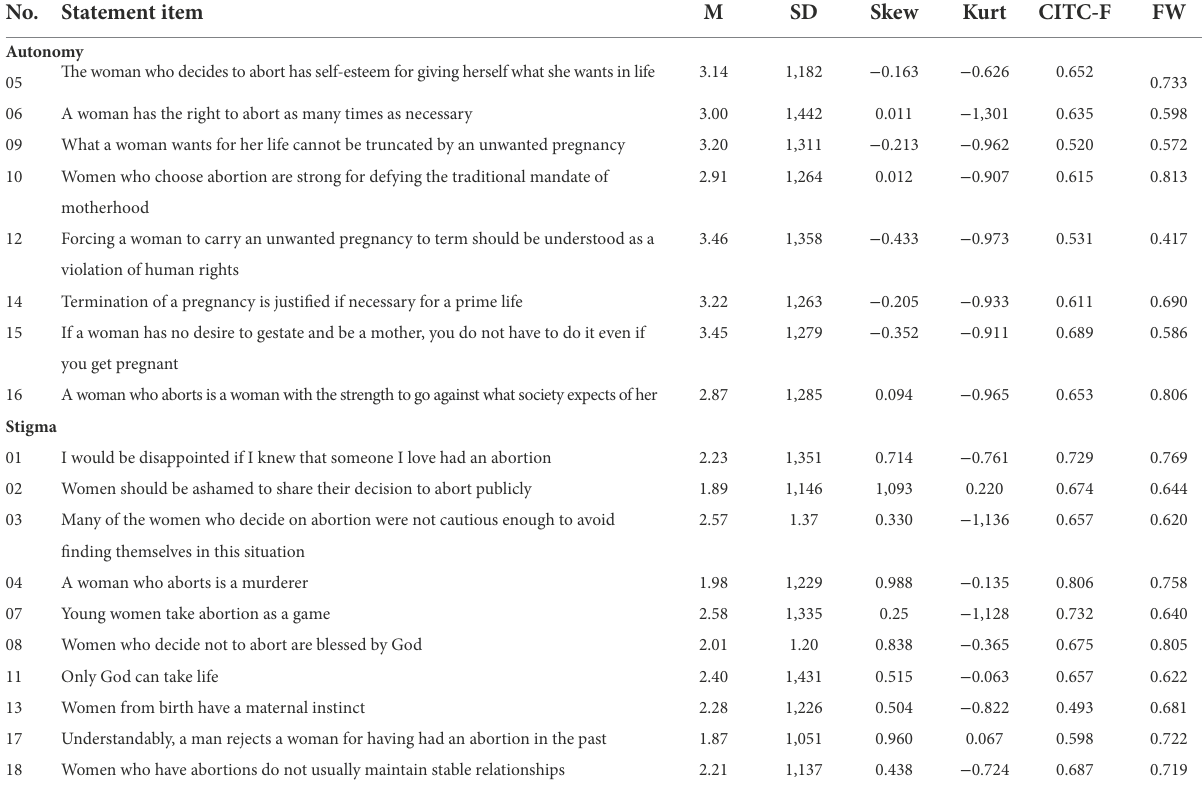
TABLE 3 Descriptive analysis of definitive items of the CAAS in the sub-sample 1 and factorial weights.